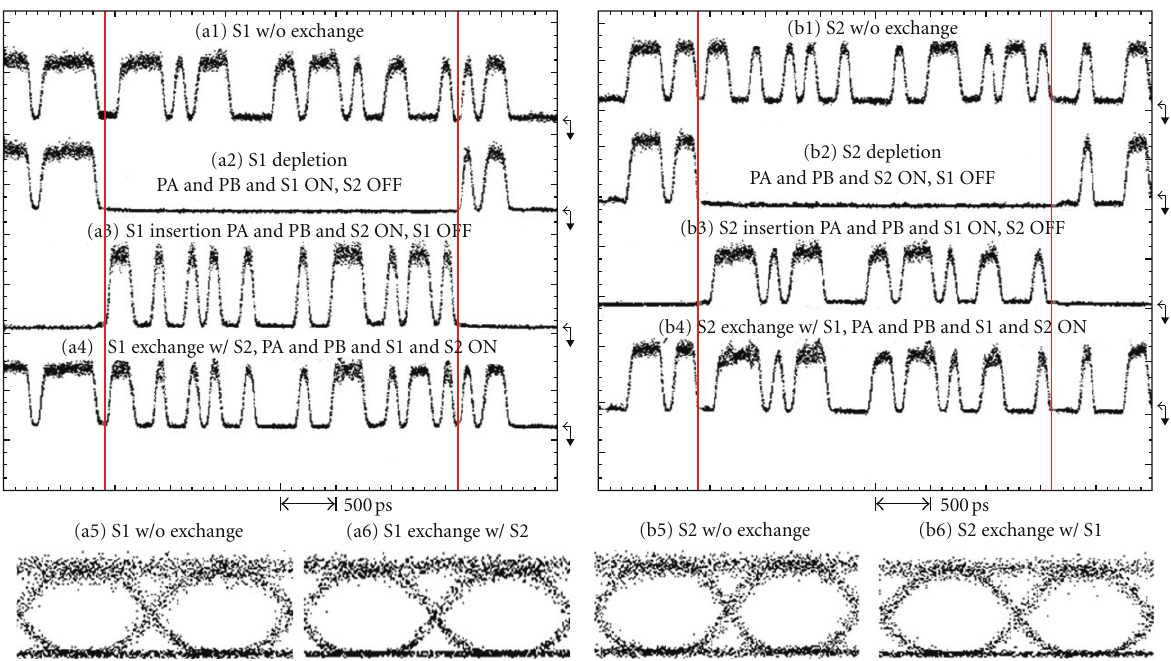
Figure 5: Measured (a1–a4) and (b1–b4) temporal waveforms and (a5), (a6), (b5), and (b6) eye diagrams of 10Gbit/s data exchange.